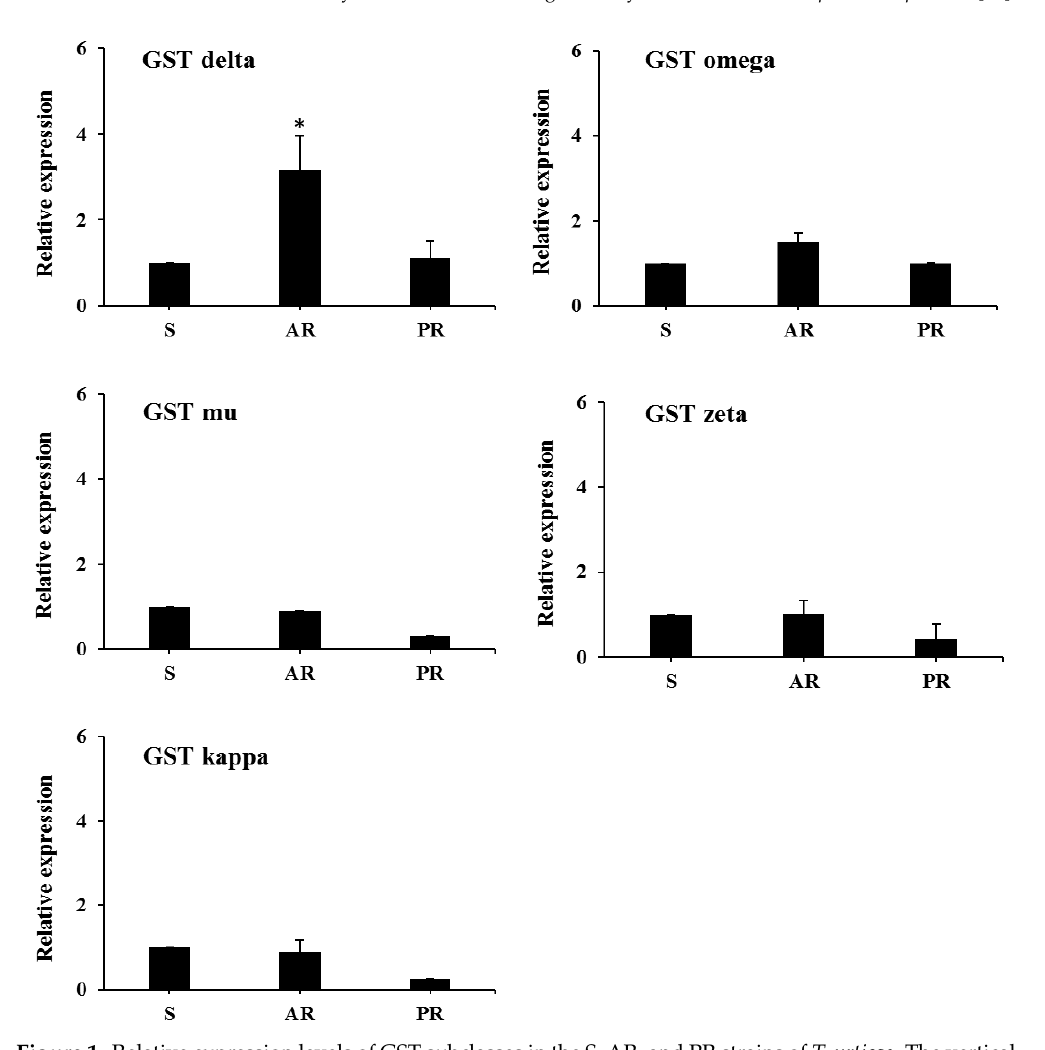
Two populations of T. urticae were selected for 16 years for acequinocyl or pyridaben resistance. They had a high resistance to each of the acaricides. Adults and eggs of the AR strain showed cross-resistance to pyridaben, but adults and eggs of the PR strain showed relatively low cross-resistance to acequinocyl. Other acaricides to which adults of the AR strain showed cross-resistance were etoxazole and spiromesifen. However, eggs of the AR strain were not. Adults of the PR strain showed cross-resistance to cyenopyrafen, cyflumetofen, etoxazole, and spiromesifen, and eggs of the PR strain showed cross-resistance to azocyclotin, cyflumetofen,